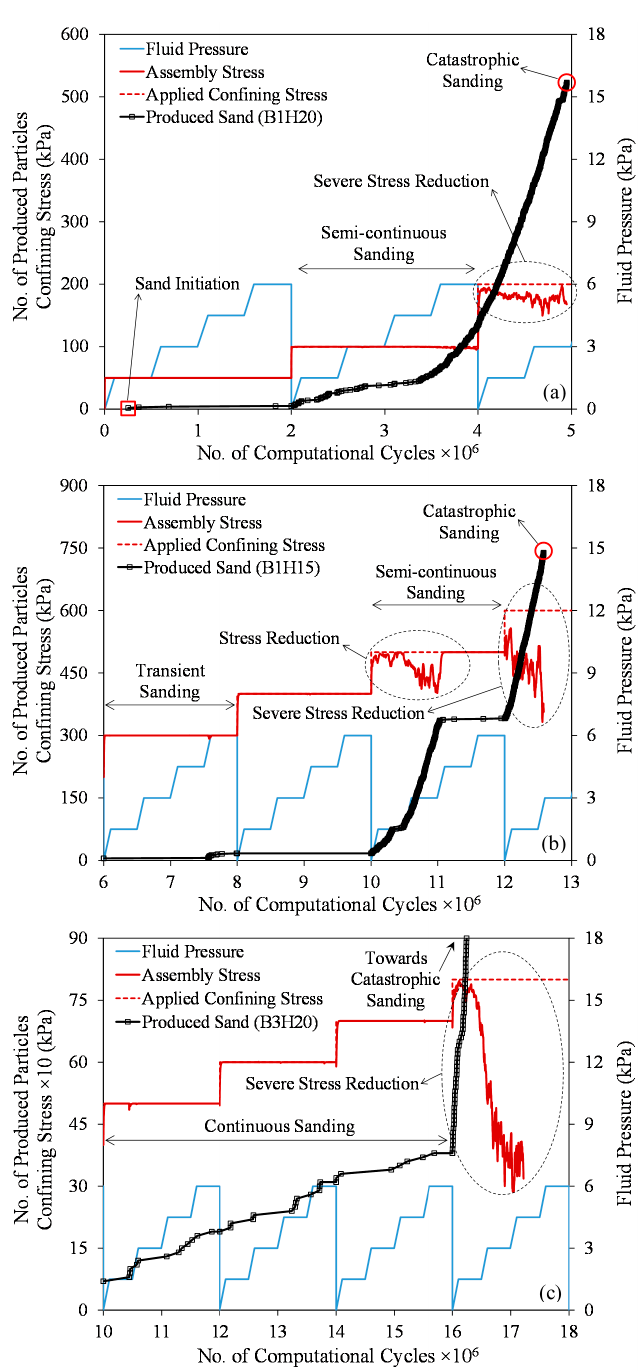
Figure 12. No. of produced particles vs. DEM cycles for the: ( a ) B1H20 model; ( b ) B1H15 model; and ( c ) B3H20 model.